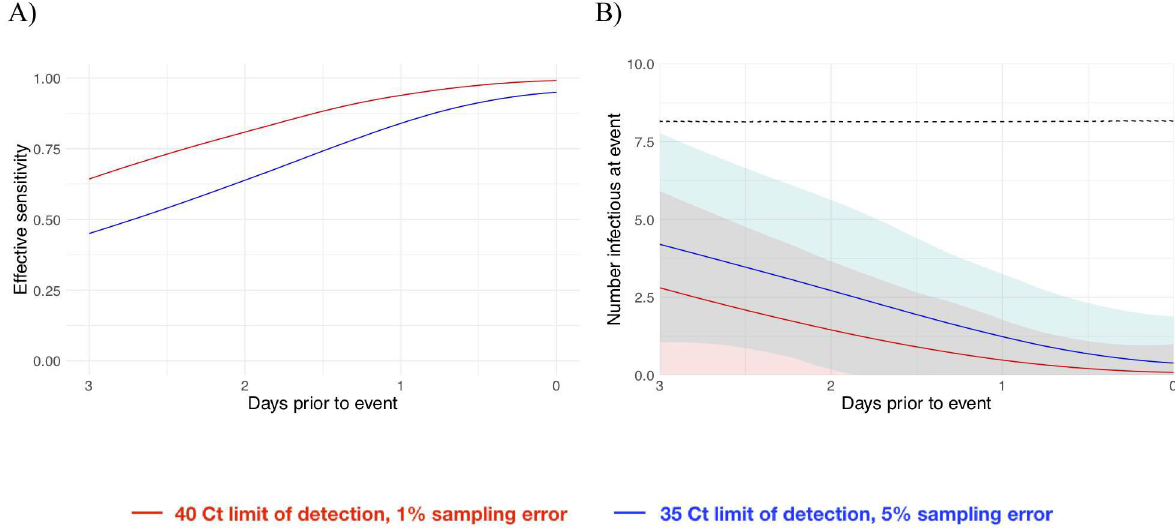
Fig 5. Effective sensitivity and expected number of infectious attendees at an event, for tests with varying sensitivity. (A) Effective sensitivity for a test with limit of detection of 40 Ct and 1% sampling error probability (red) and limit of detection of 35 Ct and 5% sampling error probability (blue). (B) Number of infectious individuals expected to attend an event of size 1,000 assuming a population prevalence of 2% infectious individuals for a test with limit of detection of 40 Ct and 1% sampling error probability (red) and limit of detection of 35 Ct and 5% sampling error probability (blue). Shaded bands represent 90% prediction intervals generated from the quantiles of 1,000 simulated events and capture uncertainty both in the number of infectious individuals who would arrive at the event in the absence of testing and in the probability that the test successfully identifies infectious individuals. The dashed line depicts the expected number of infectious individuals who would attend the gathering in the absence of testing. Underlying data are available at https://github.com/gradlab/CtTrajectories/tree/main/figure_data/Fig5 [10].